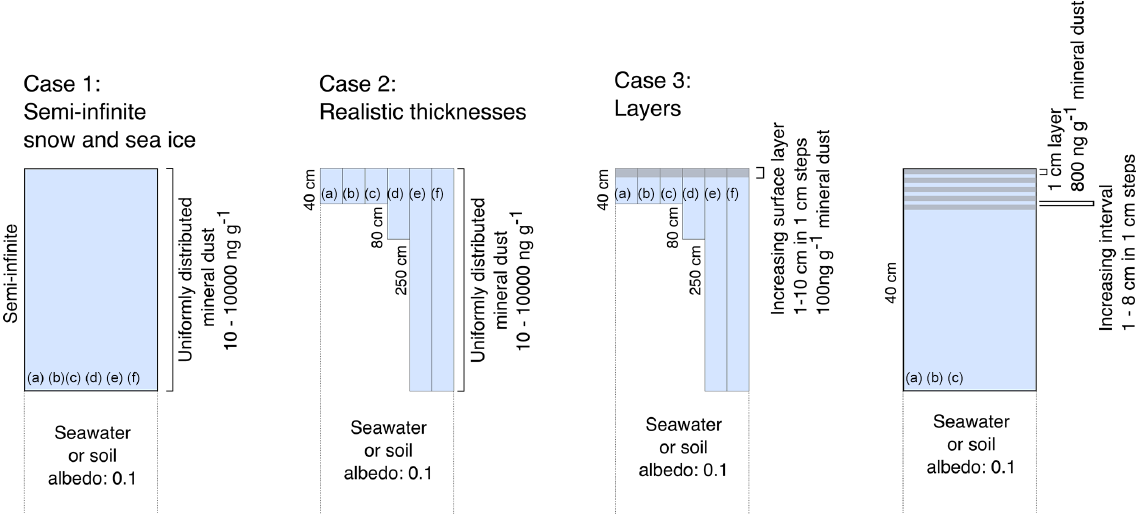
Figure 3. Snow and sea ice configurations modelled for (a) cold polar snow, (b) coastal windpacked snow, (c) melting snow, (d) first-year sea ice, (e) multi-year sea ice, (f) melting sea ice (not to